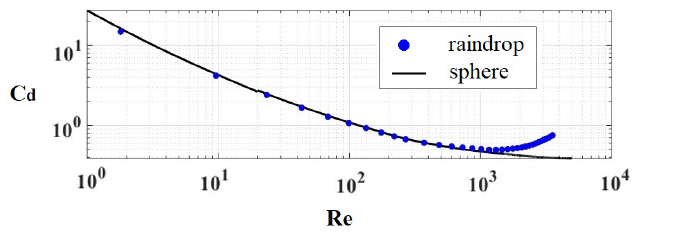
Figure 1. Drag coefficients of water drops in stagnant air falling at their terminal velocities (blue dots) (data taken from Gunn and Kinzer [11]) in comparison to the drag curve of rigid spheres suggested by Clift [22].